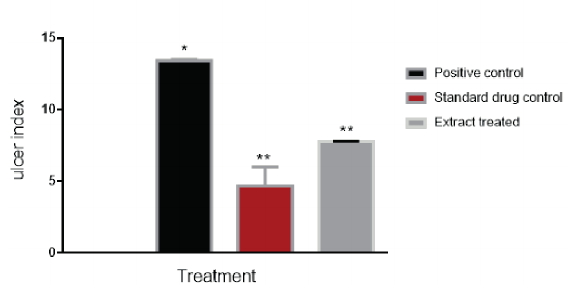
Figure 5 - Calculation of Ulcer index (UI) from negative control, positive control, standard drug control and Myristica fragrans extract treated (200mg/kg) group of rats (* P <0.05; compared to negative control group, ** P <0.05 compared to positive control group; n=5).